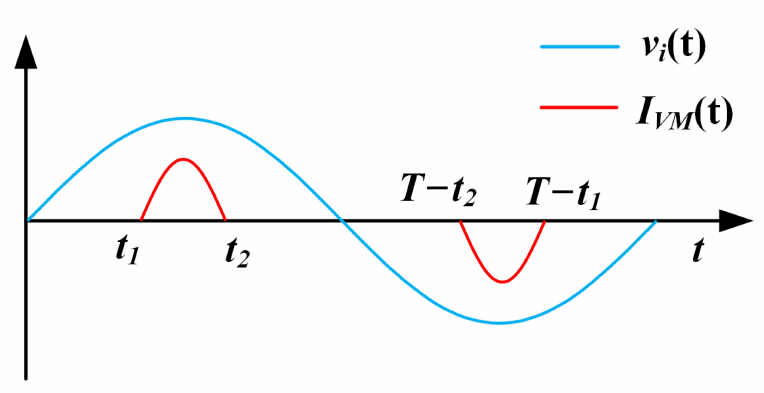
Figure 12. The current and voltage waveforms of source when vibration